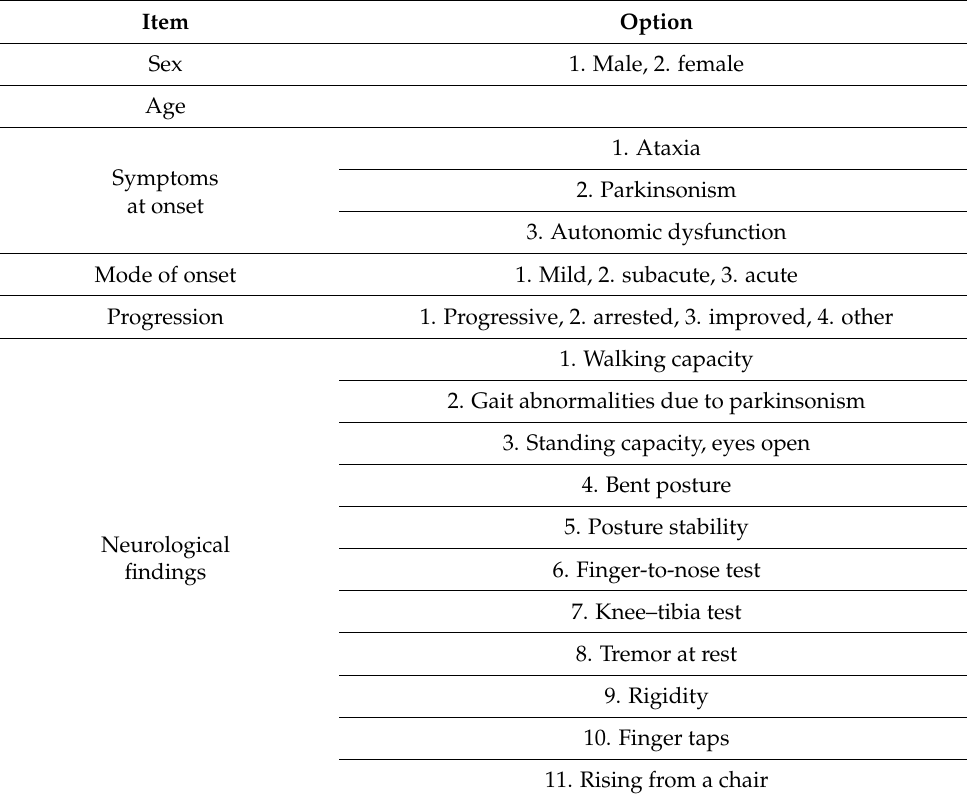
Table 1. Form for registration of cases of